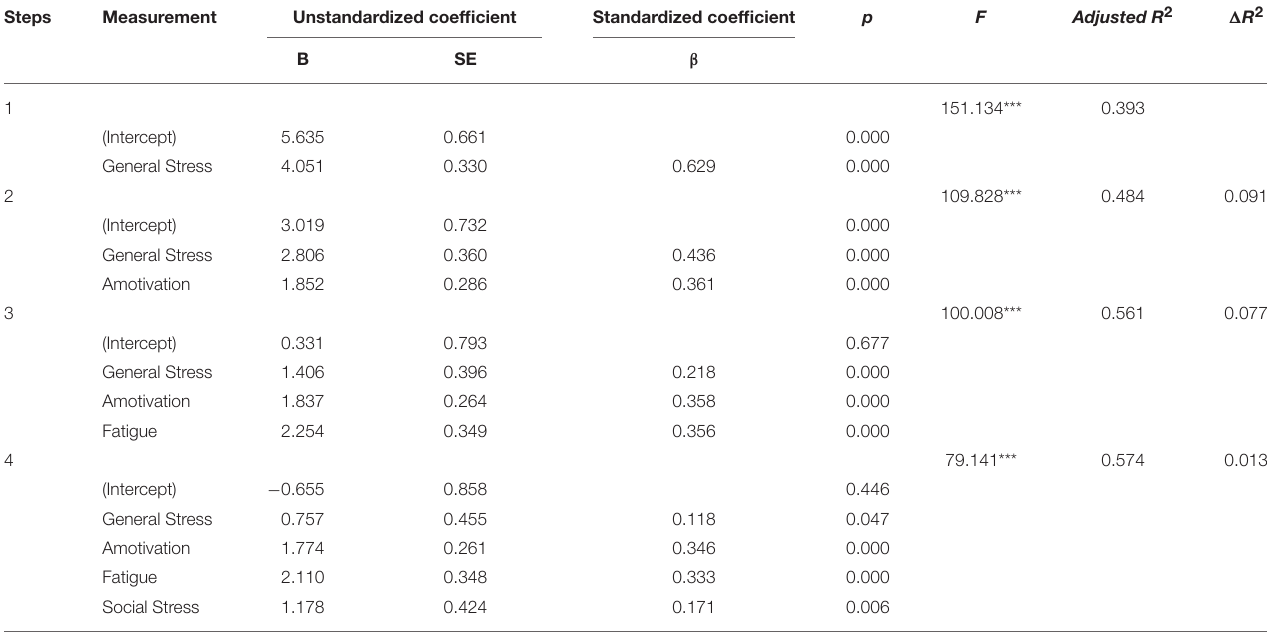
TABLE 2 | Results from stepwise multiple regression of all scales of the RESTQ-Basic, RESTQ-Coach, RESTQ-Work, AWS, and CMQ on Emotional Exhaustion of the